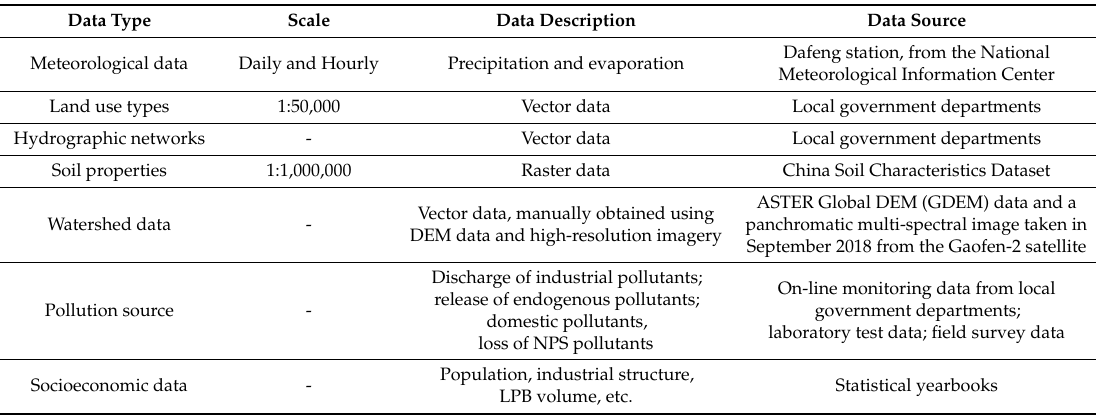
Table 2. Data and their sources.